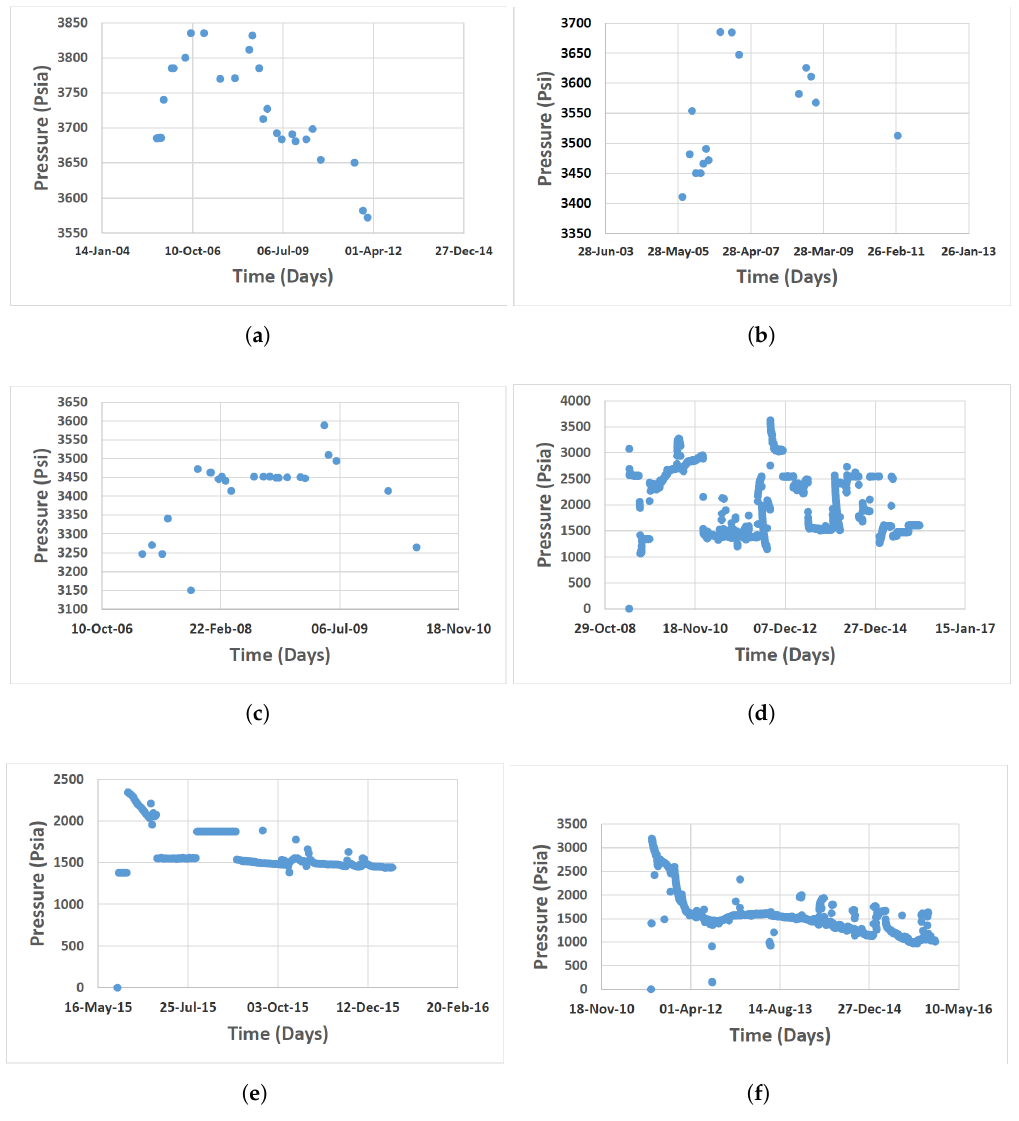
Figure 6. Pressure profile for wells ( a ) X6Y13W1; ( b ) X6Y16W2; ( c ) X5Y9W3; ( d ) X7Y29W4; ( e ) X8Y27W5; and ( f ) X9Y38W6. In all cases X indicates the field, Y the reservoir and W the well and the associated figures signifies the number of the field, reservoir or well in the Block K investigated (Courtesy: Sonangol